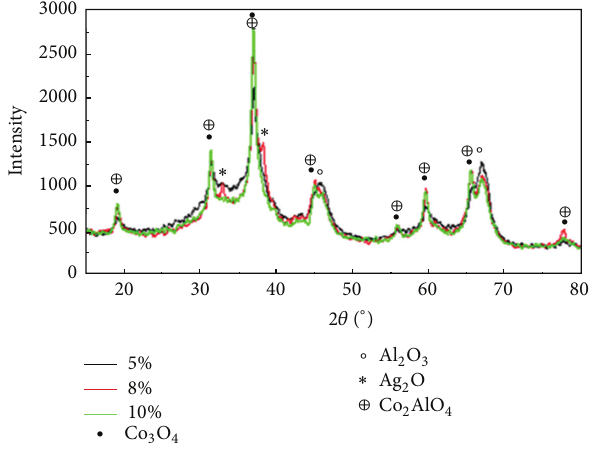
Figure 5: The XRD of different cobalt